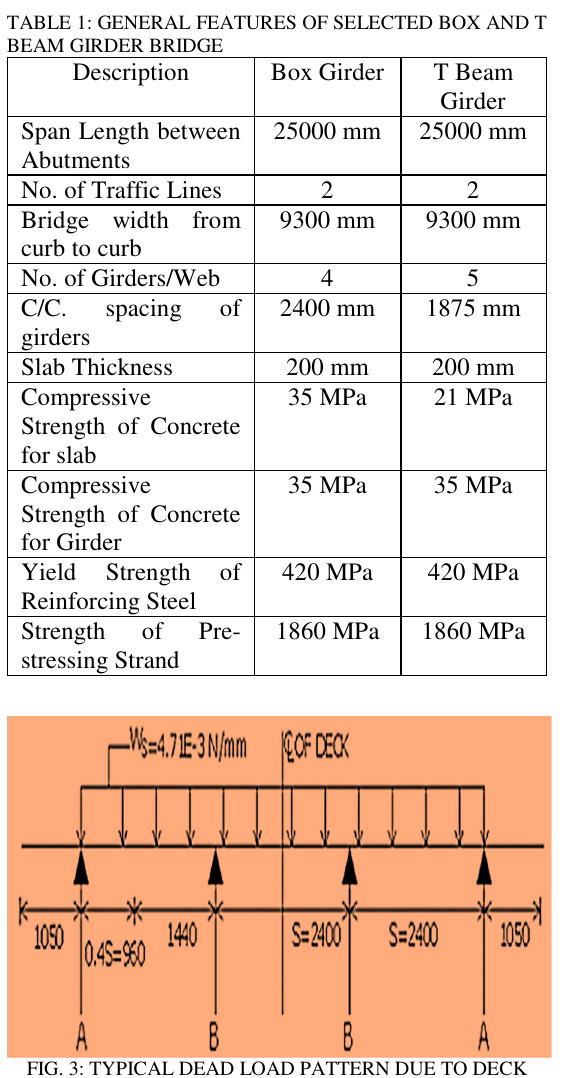
FIG. 3: TYPICAL DEAD LOAD PATTERN DUE TO DECK SLAB IN CASE OF BOX GIRDER BRIDGE Influence Line Diagrams (ILDs) for application of live load at different locations were drawn and critical i.e.